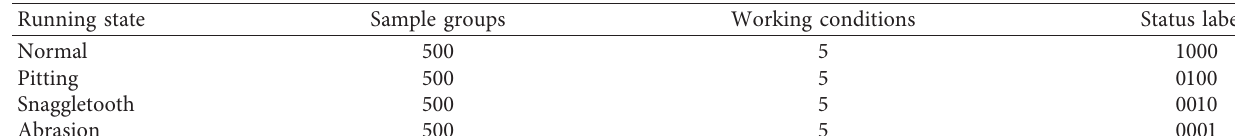
Figure 4: Test bed of the transmission system: (a) overview and (b) diagram. Table 1: Four running states of the gearbox system.